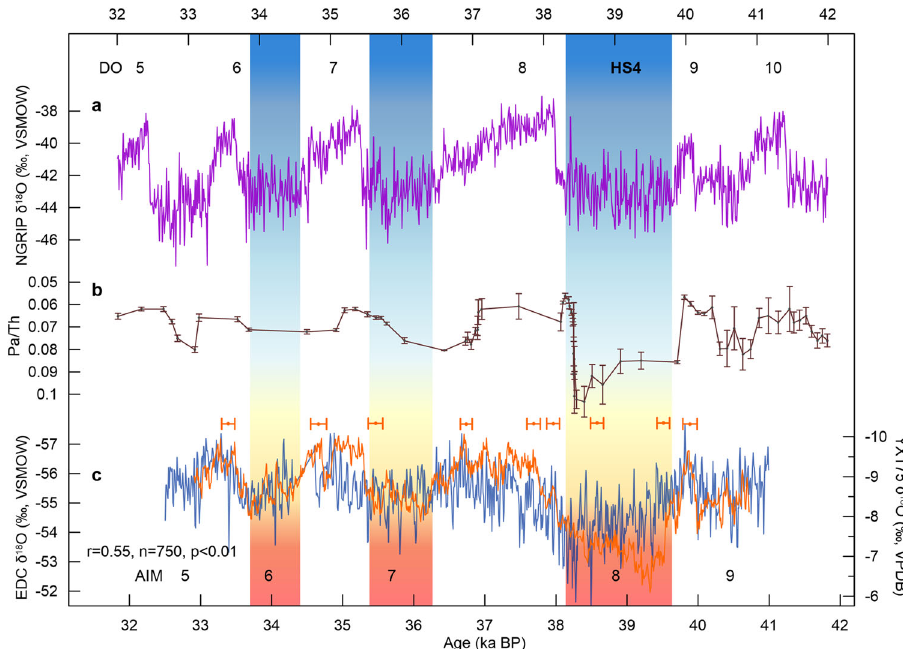
Fig. 1 Climate indices from 42 to 32 ka BP during the MIS3. a δ 18 O ice record from NGRIP ice core on the GICC05 chronology (purple) 1,86 . b Pa/Th ratios and error bars (SD) from the North Atlantic, indicating the AMOC strength (brown) 62 . c Our δ 18 O calcite record (orange) overlapped with δ 18 O ice record from the Antarctic EDC ice core on the AICC2012 chronology (blue) 7,87 . Numbers indicate DO events, AIM events and HS4. Orange dots indicating 230 Th dating results and SD errors. Pearson correlation coef fi cient is calculated between our δ 18 O calcite and EDC δ 18 O record, denoted on the bottom-left